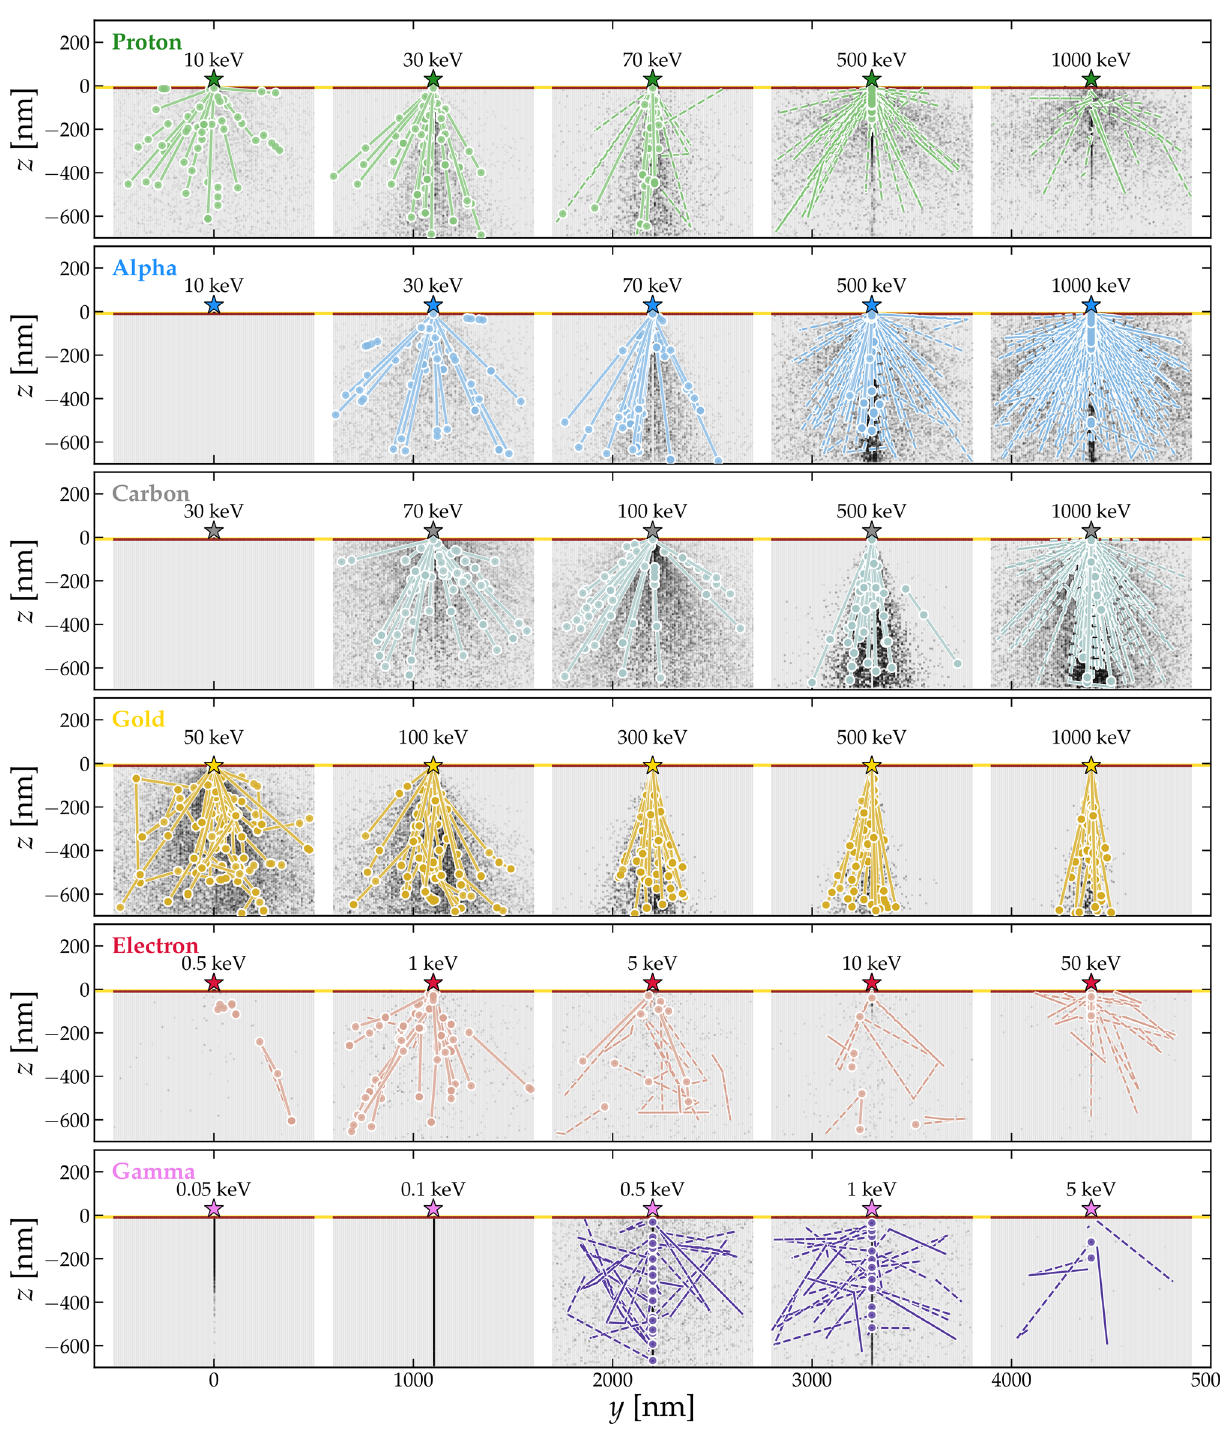
Fig. 11 Additional detailed images of strand breakage from top-down beams. Each row corresponds to a different beam particle, and has five panels for different beam energies. The thick lines connected by circles correspond to the primary particle track, whereas the thinner dashed lines correspond to secondary particles generated by a primary inter-